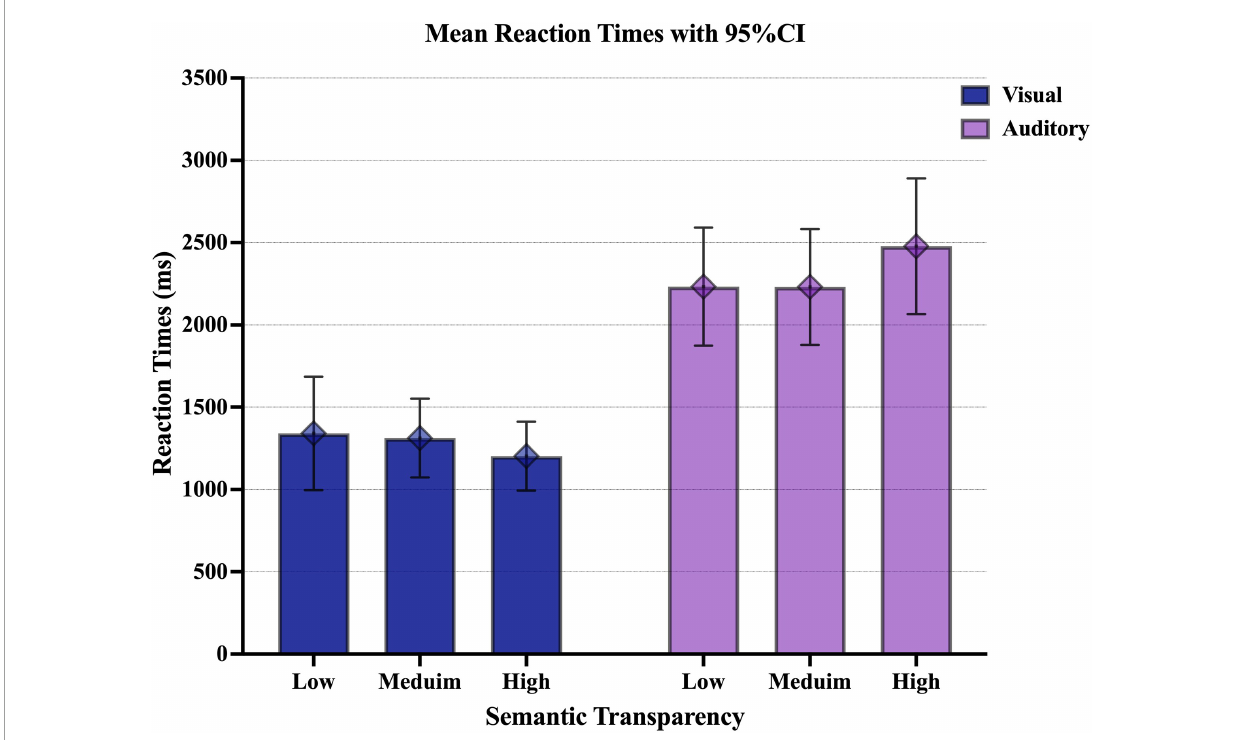
FIGURE2 Graph of the mean reaction times upon visual or auditory presentation of Japanese collocations with different degrees of semantic transparency. The error bar shows the 95% confidence interval (CI).